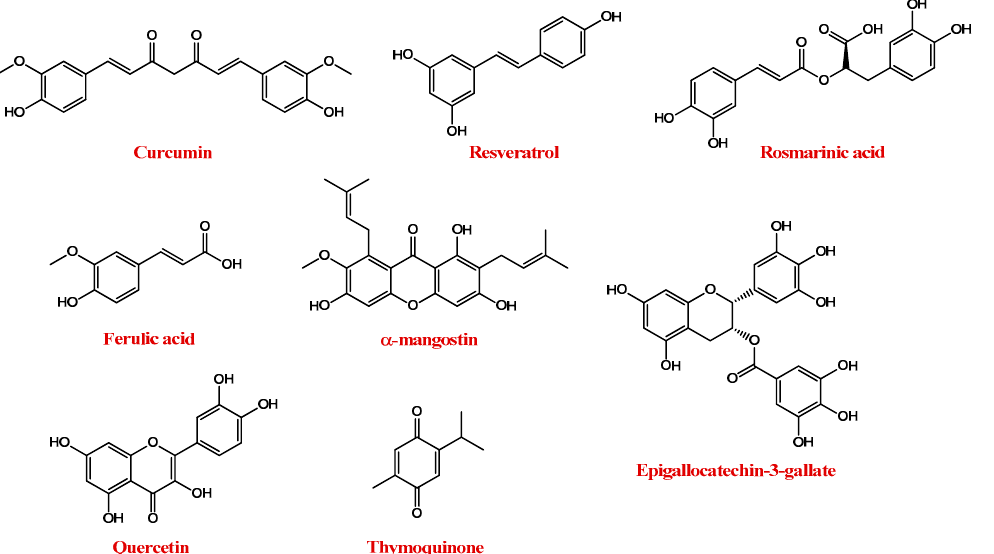
Figure 5. Molecular structures of polyphenol compounds here described.